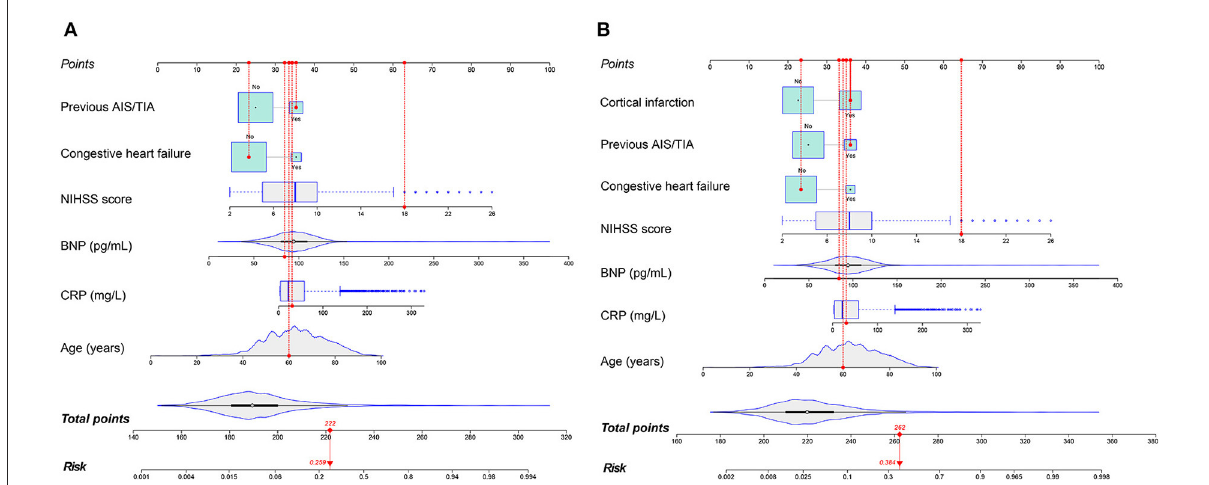
FIGURE4 The nomograms to predict the probability of AFDAS after AIS patients from the training cohort. The patient was 60 years old with a history of stroke and no history of heart failure. During hospitalization the NIHSS score was 18, the C-reactive protein was 30.4 mg/L and the BNP was 84.3 pg/mL. The patient had a total score of 222 and a probability of atrial fibrillation of 25.9% (model 1) (A) . When the neuroimaging variable (Cortical infarction) was added, the patient had a total score of 262 and a 38.4% probability of atrial fibrillation (model 2) (B)